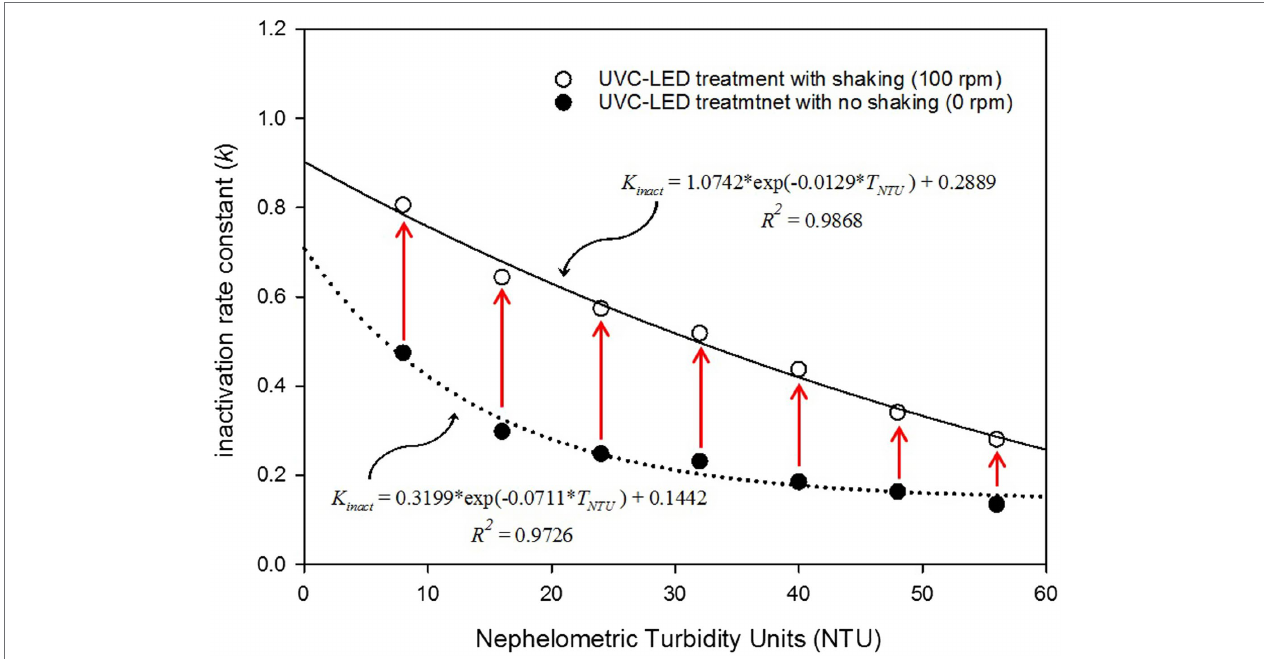
FIGURE 2 | Relationship between the inactivation rate constant ( k inact ) values and nephelometric turbidity